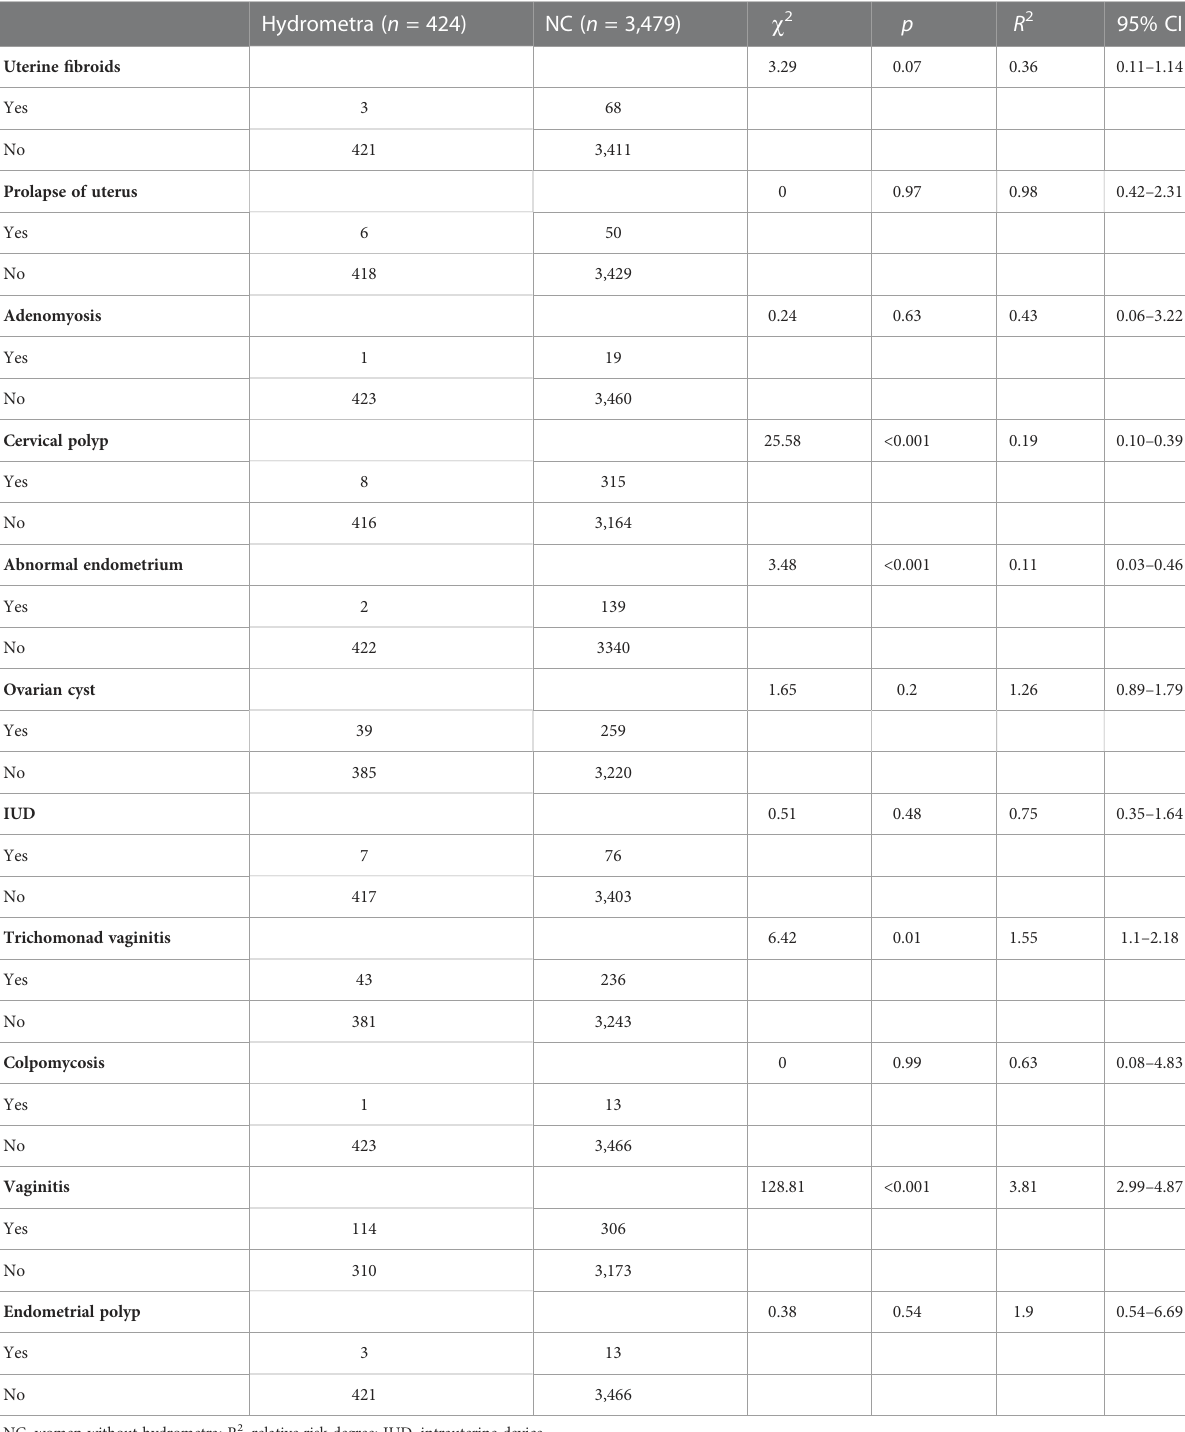
TABLE 1 Univariate analysis of risk factors for